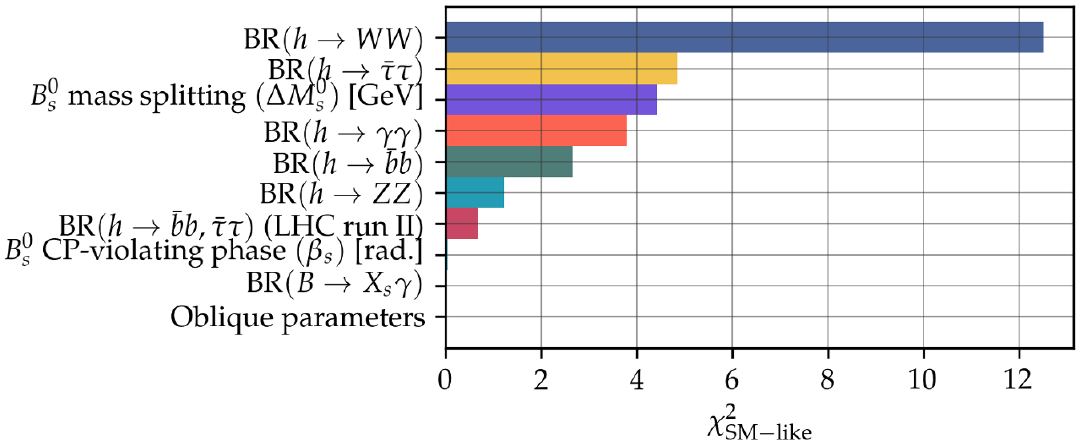
Figure 7 . (cid:31) 2 contributions due to experimental constraints in the limit of the Standard Model, s (cid:12) (cid:0) (cid:11) ! 1 and ^ (cid:24) U = ^ (cid:24) D = 0. ij ij